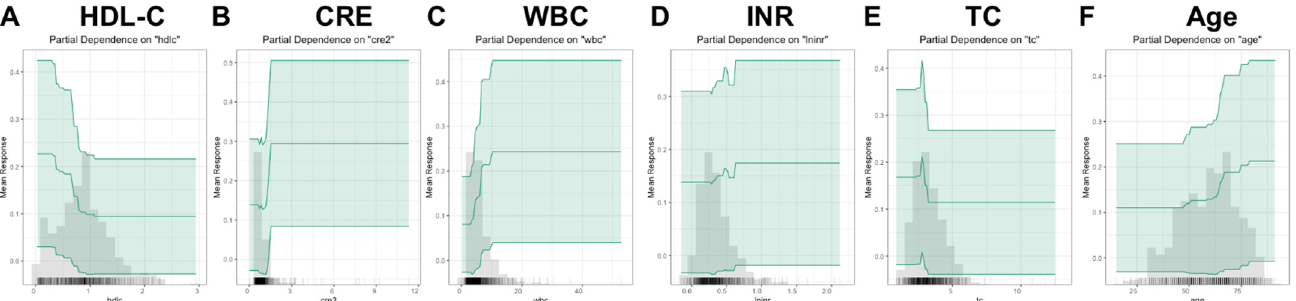
Figure 4. PDP for the key variables in the XGBoost model. The chart shows that creatinine, white blood cell, international normalized ratio, and age showed upward trends with the mortality, while high-density lipoprotein cholesterol and total cholesterol showed opposite trends. Abbreviations: PDP, partial dependence plot; HDL-C, high-density lipoprotein cholesterol; CRE, creatinine; WBC, white blood cell count, INR, international normalized ratio; TC, total cholesterol.